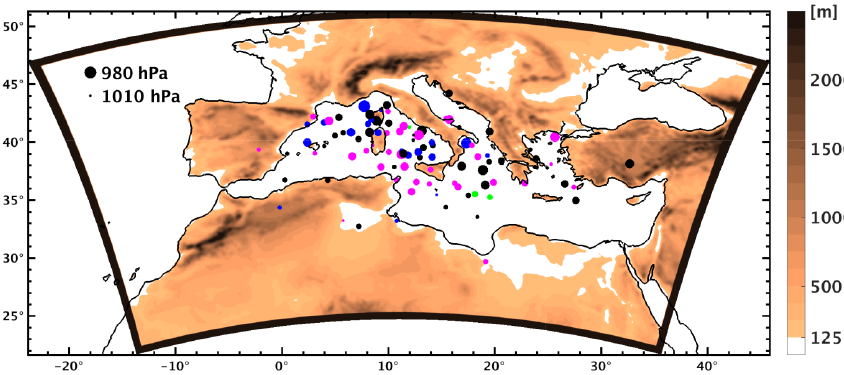
Figure 1. Simulations domain and orography (colour). Dots depict the locations of the 100 cyclones at their mature stage. The size of the dots is proportional to the cyclones’ central mean sea level pressure (see legend upper left corner of the domain). Dot colours depict a certain season: black for winter, magenta for spring, green for summer and blue for